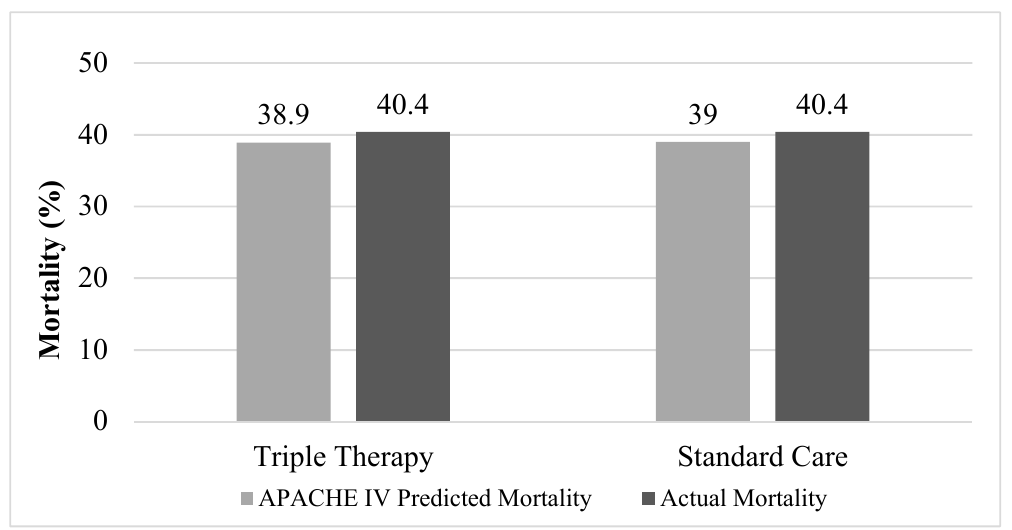
Figure 1. APACHE (Acute Physiology and Chronic Health Evaluation) intravenous (IV) predicted mortality compared to actual mortality. Actual mortality in triple therapy and standard care groups were the same at 40.4% ( p = 1.000). Table 2. Outcomes in patients who received triple therapy versus no triple